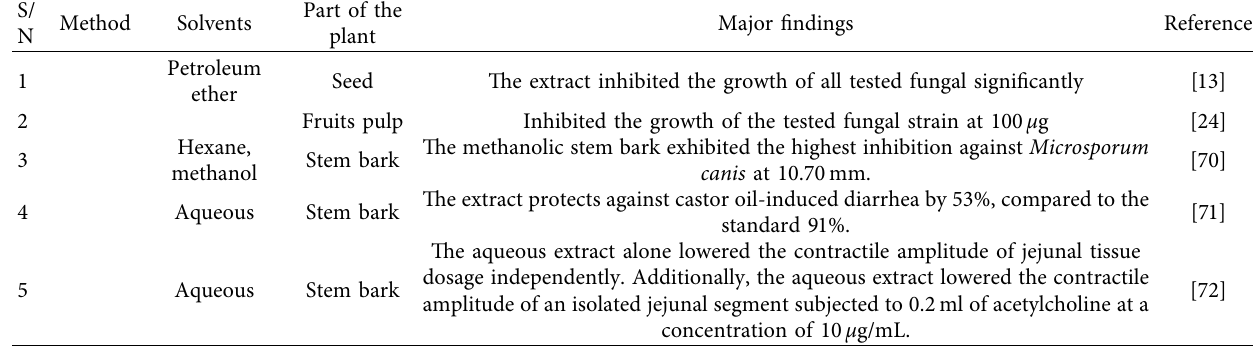
Table 5: Antifungal activity of D. microcarpum .